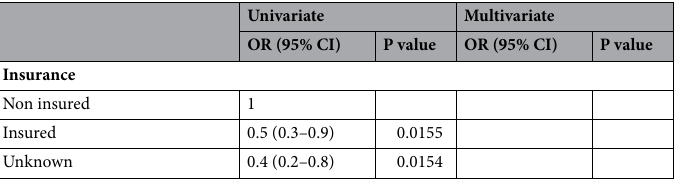
Table 2. Risk factors associated with the distant metastasis in patients with T1 stage colorectal cancer. CI confidence interval, OR odds ratio. *Single includes divorced/separated/widowed/unmarried. The